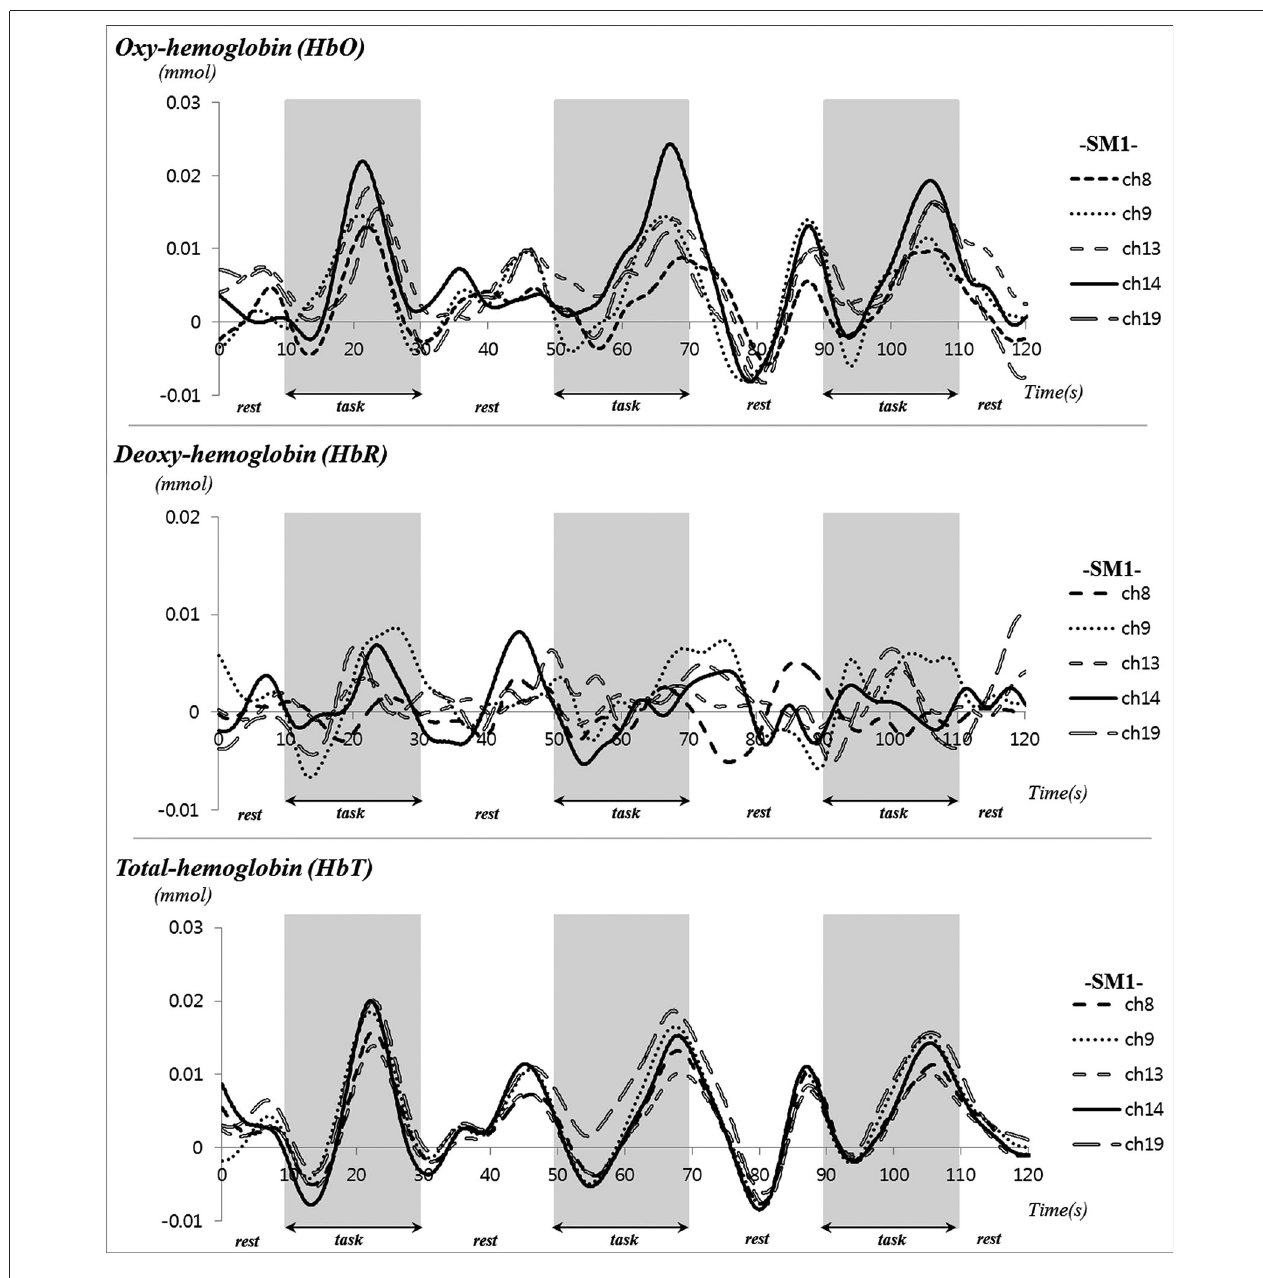
FIGURE 3 | Time course of hemodynamic responses for oxy-hemoglobin (HbO) deoxy-hemoglobin (HbR) and total-hemoglobin (HbT) in region of interest on the sensory motor